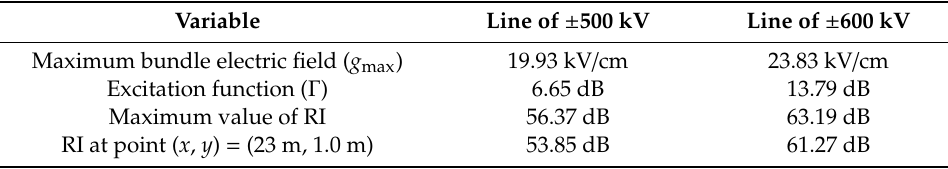
Table 3. Results of the calculations for the bipolar HVDC lines.